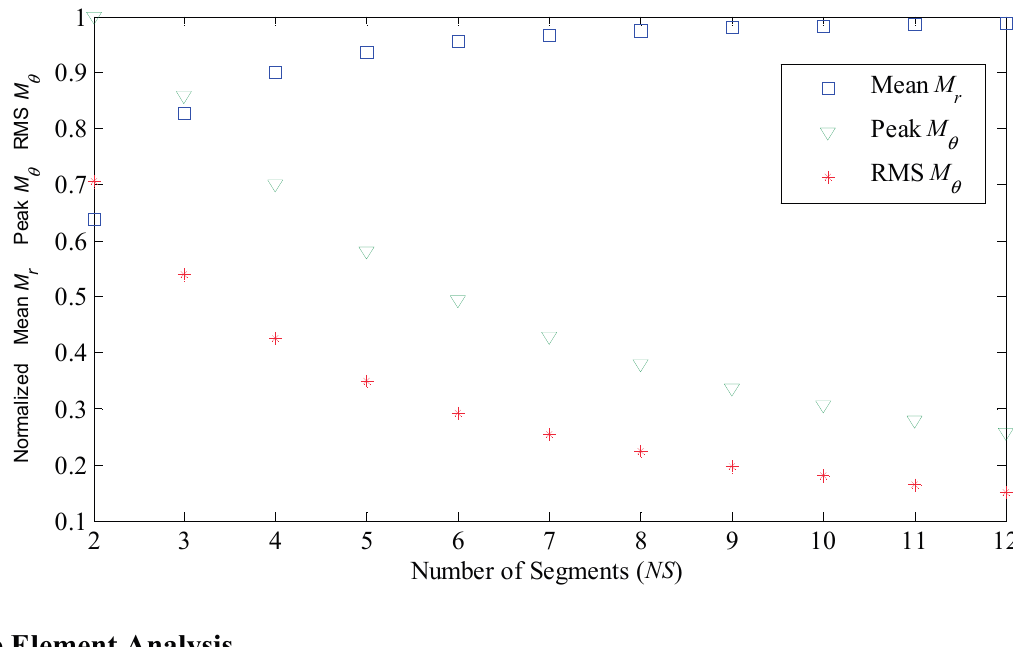
Figure 5. Normalized mean radial component of magnetization for parallel magnetized ring-shaped magnets, and normalized peak value and RMS value of circumferential component for 2 to 12 segments of permanent